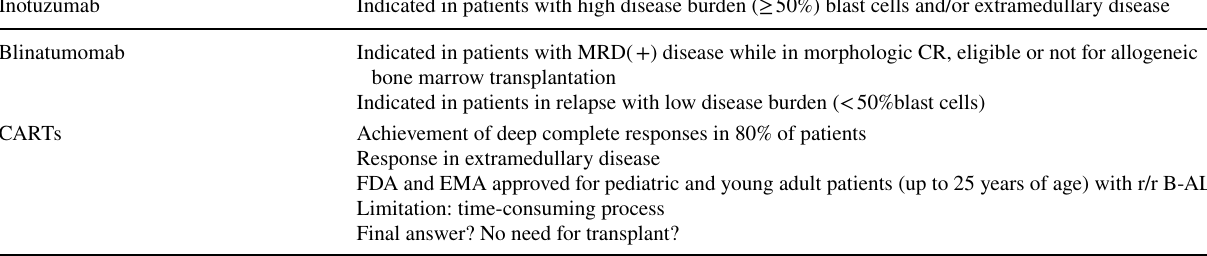
Therapeutic management of relapsed/refractory (r/r) B-ALL (ABCs) FDA Food and Drug Administration, EMA European Medicines